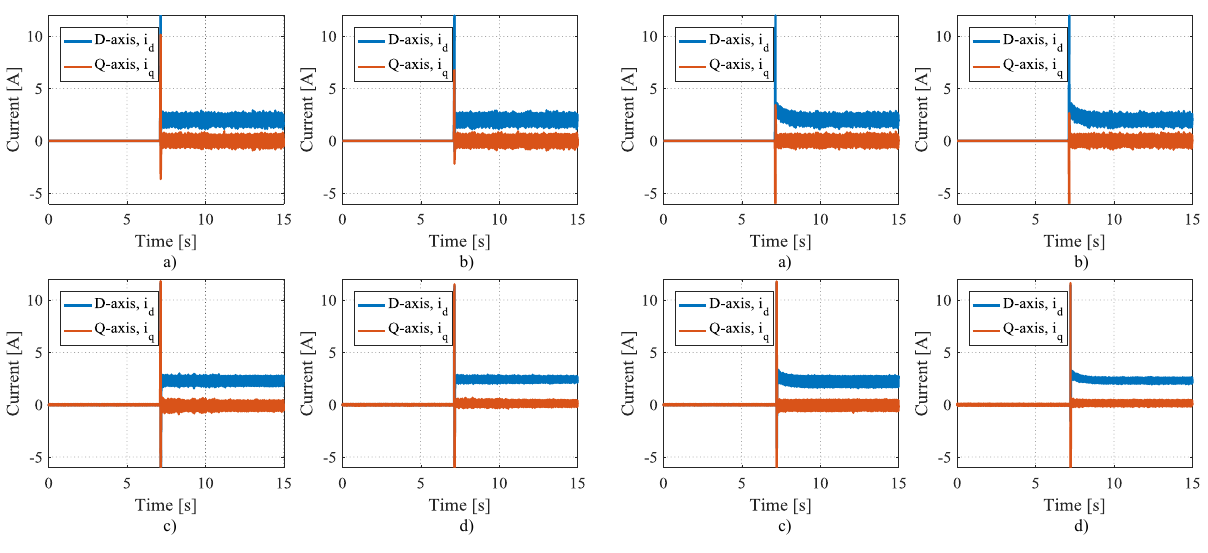
Figure 11: Simulated and measured DQ currents dur- ing the rotor lift-up when using the LQR controller. Simulation of the DQ axis cur- rent of the D-end and the ND-end motor are shown in a) and b), respectively. The mea- sured DQ axis currents of the D-end and the ND-end motor are shown in c) and d), respectively. Steady state RMS values for current in the simulation a) and b) are 2 A. For the measured steady state RMS current values c) 2.2 A and d) 2.3 A.